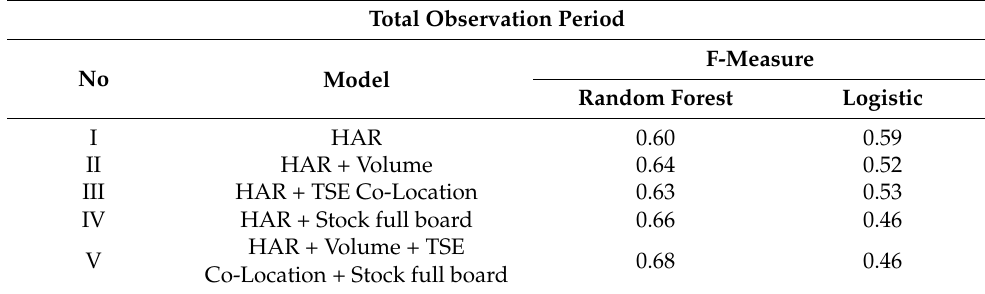
Table 3. Prediction accuracy of RV in the total observation